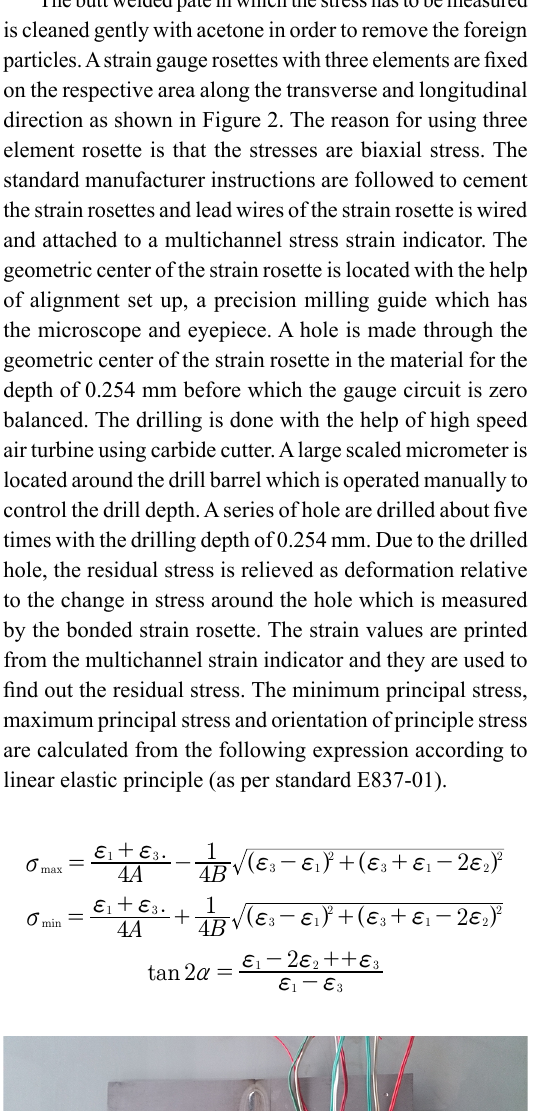
Figure 3. Residual Stress measurement –XRD. Selection of suitable tube is the important characteristics which should be done on the basis of wavelength target material and intensity on the specimen to be tested. The XRD testing equipment has been calibrated with standard titanium specimen. Titanium tube is carefully replaced and used as the source for the generation of X-ray. The measurement parameter used for conducting the experiment are given in the Table